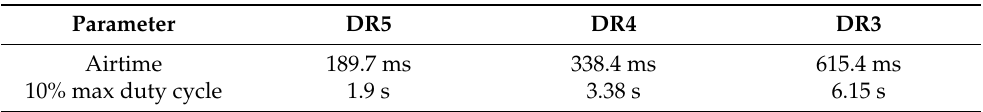
Table 1. Airtime and duty cycle for downlink packets for each data rate configuration, always considering a bandwidth of 125